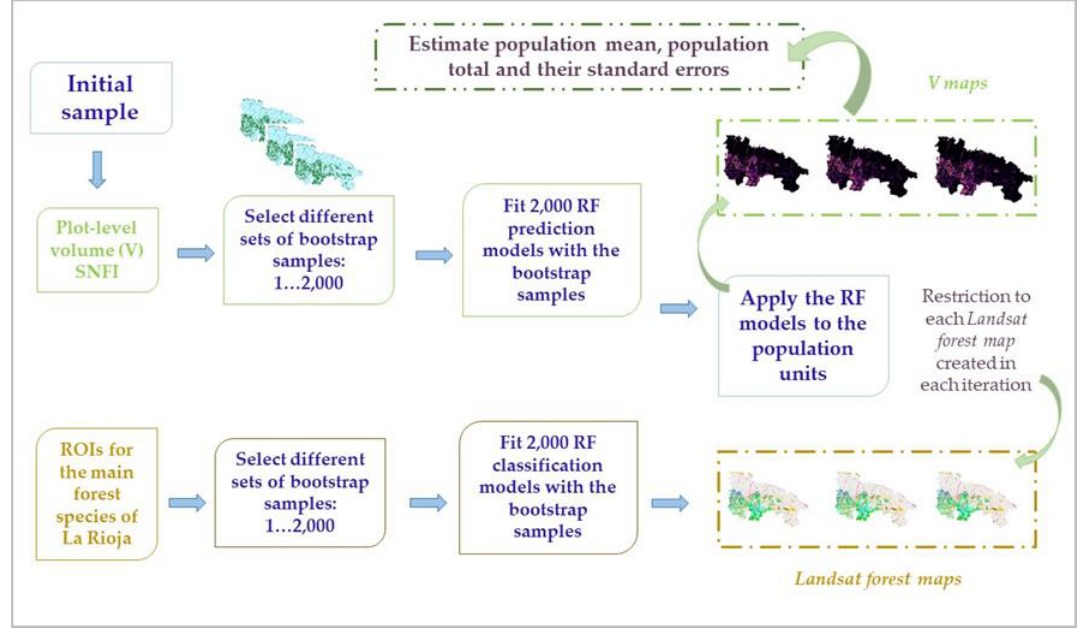
Figure 4. Wild and pairs bootstrapping schemes used to account for uncertainty in the Landsat forest species map.